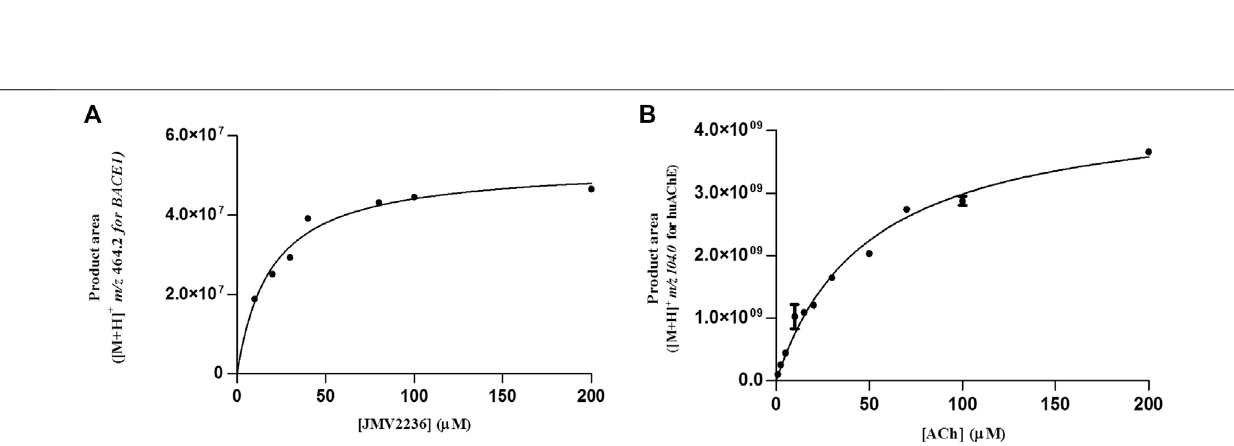
Frontiers in Chemistry |